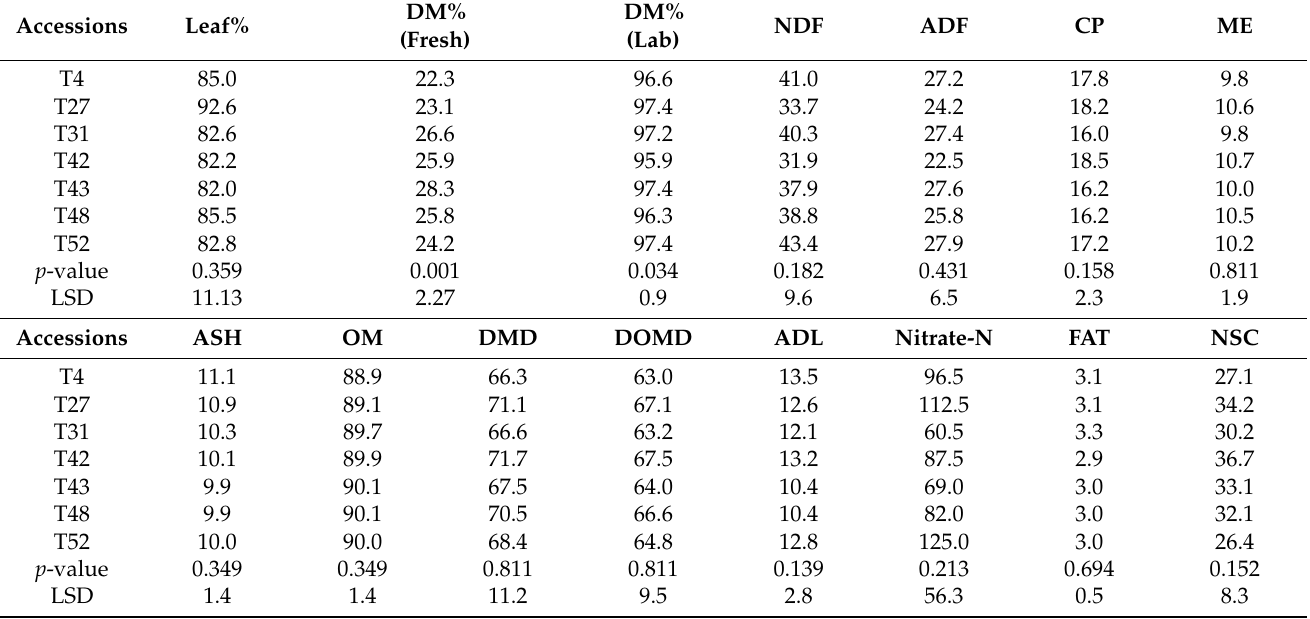
Table 2. Nutritive value of the seven accessions of tedera fed. Analysis of the representative composite samples collected at days 0 and 14 of the experimental period. (a) Leaf %, leaf to stem ratio; DM% (Fresh), dry matter of the harvest fresh tedera; DM% (Lab), dry matter after oven drying; NDF (%), neutral detergent fibre; ADF (%), acid detergent fibre; CP (%), crude protein; ME (%), estimated metabolisable energy; (b) ASH (%), ash; OM (%), organic matter; DMD (%), dry matter